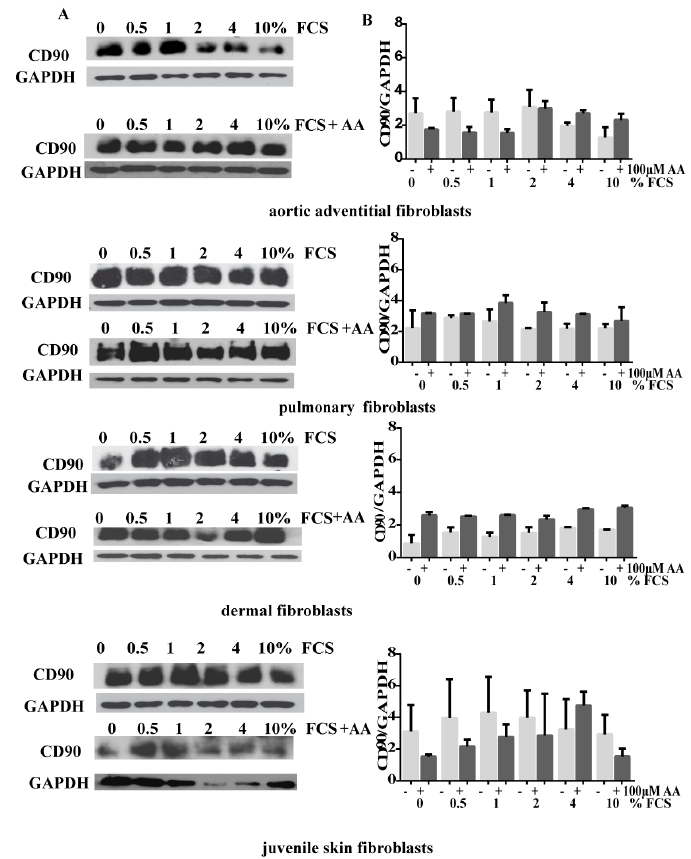
Figure 1. Expression levels of CD90 with di ff erent concentrations of fetal calf syndrome (FCS) and FCS plus 100 µ M ascorbic acid (AA) within the culture medium of di ff erent fibroblast types. ( A ) Expression levels of CD90 are illustrated by immunoblots as indicated. For normalization, protein levels of GAPDH are demonstrated. ( B ) Quantification of CD90 is present as ratio of CD90 / GAPDH signal. Data are the mean of at least 2–4 experiments with polyclonal and monoclonal Abs for